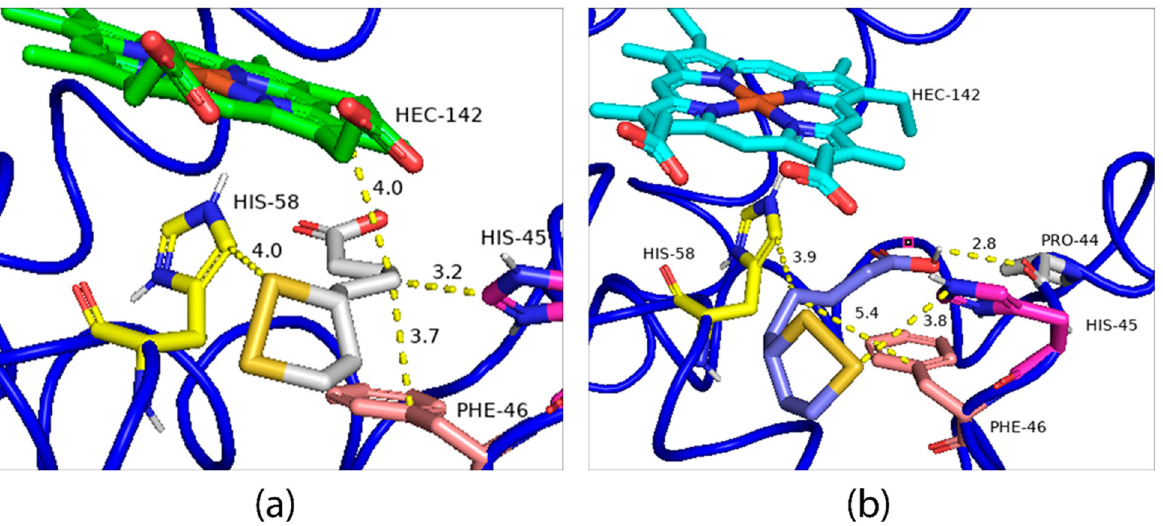
Figure 10. Lower energy R-ALA ( a ) and S-ALA ( b ) configurations obtained through molecular docking.